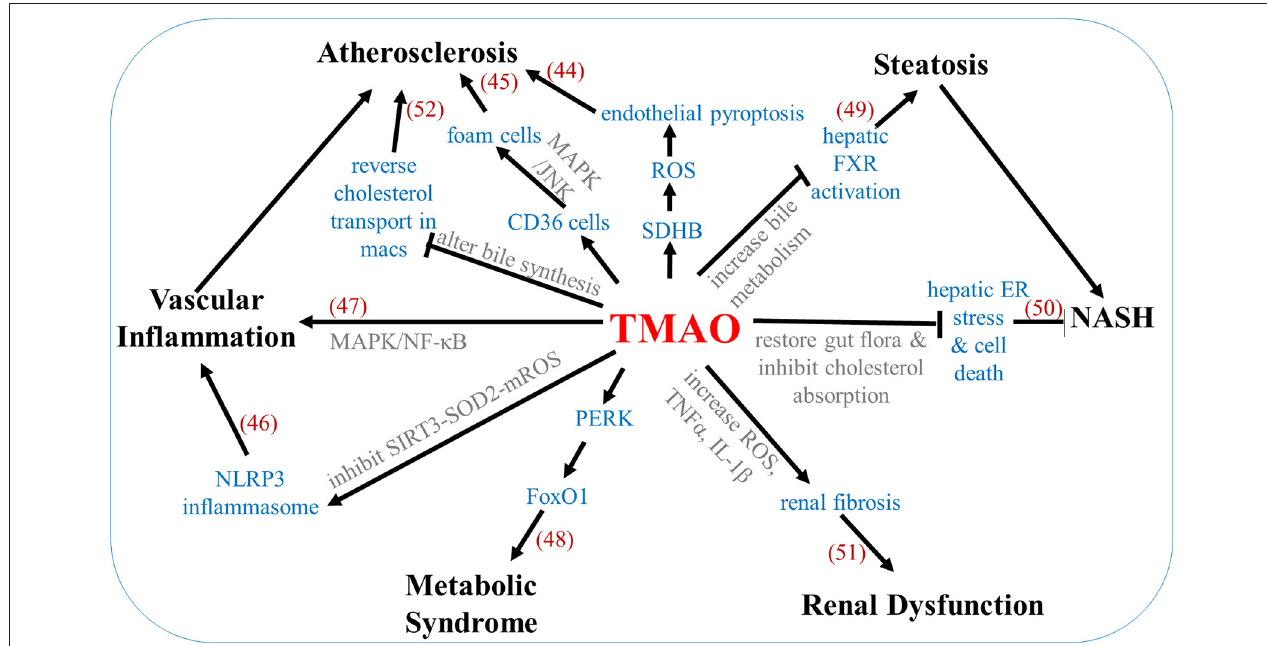
FIGURE 3 | Mechanisms underlying TMAO-associated complications. Numbers in parentheses indicate supporting references.